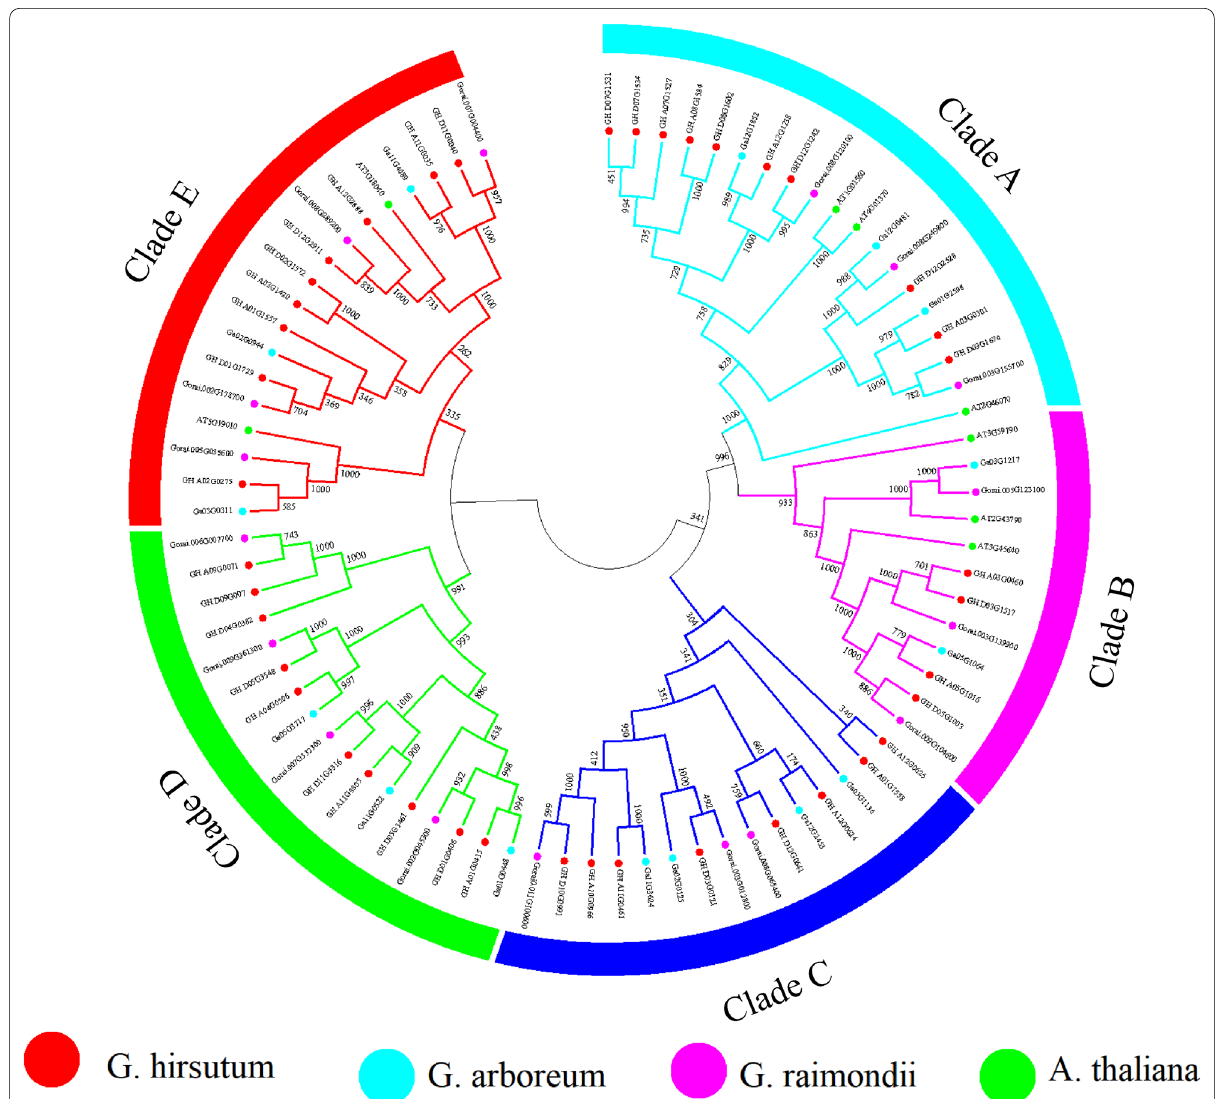
Fig. 1 Phylogenetic analysis of MAPK proteins. Different clades of MAPKs are represented by Letters A-E. MAPKs are genes highlighted in different colors, G. hirsutum highlighted in red, G. arboreum highlighted in cadet blue while G. raimondii highlighted in violet and A. thaliana highlighted in